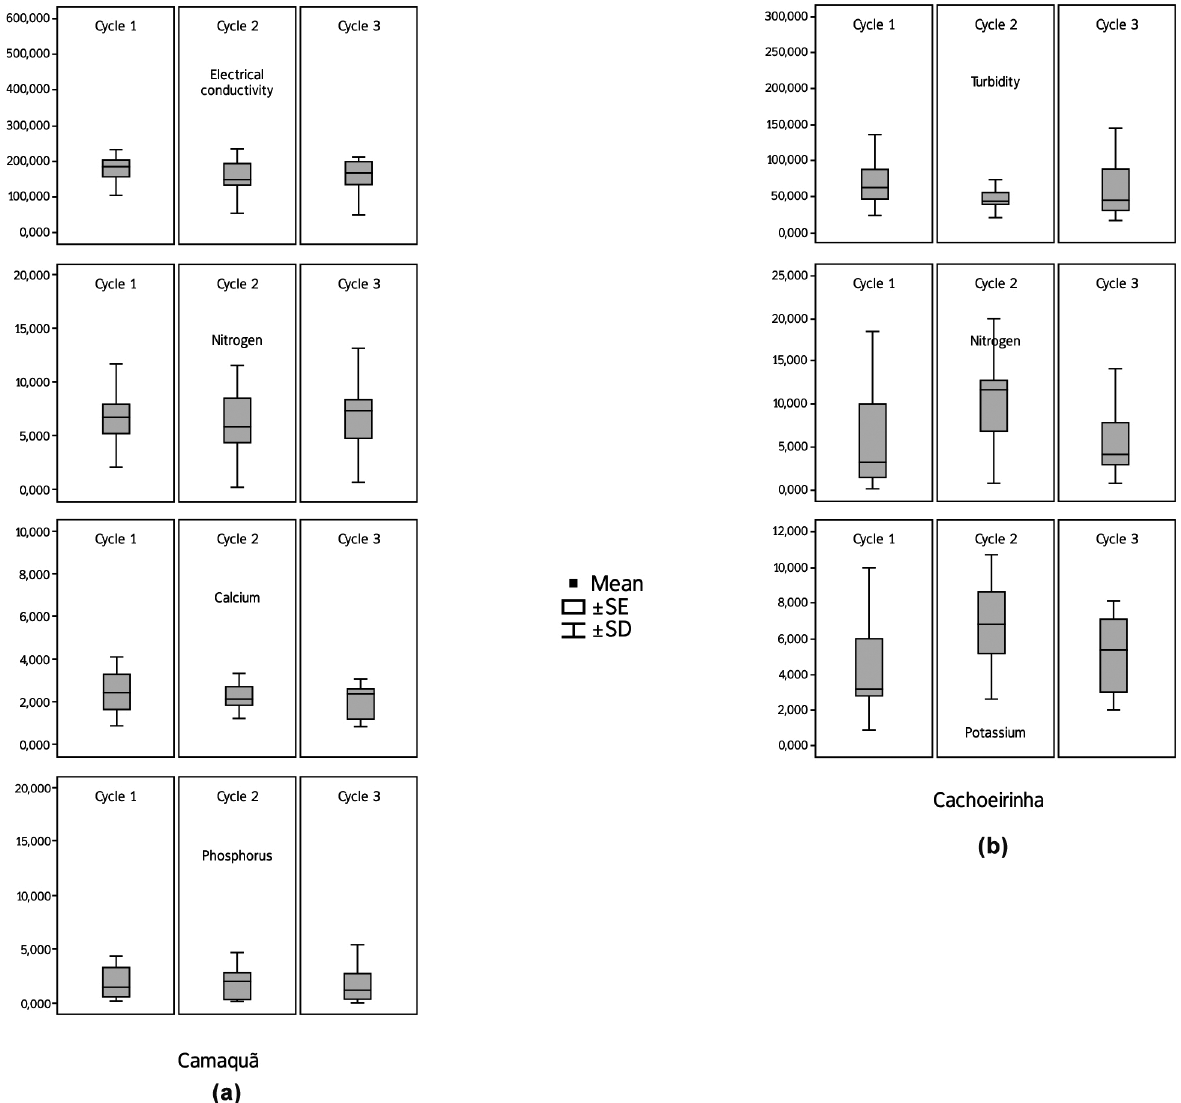
Figure 6 - Box-and-whisker plot representing the main discriminant variables between cycles of rice for 3 years. ( a ) Camaquã; ( b )